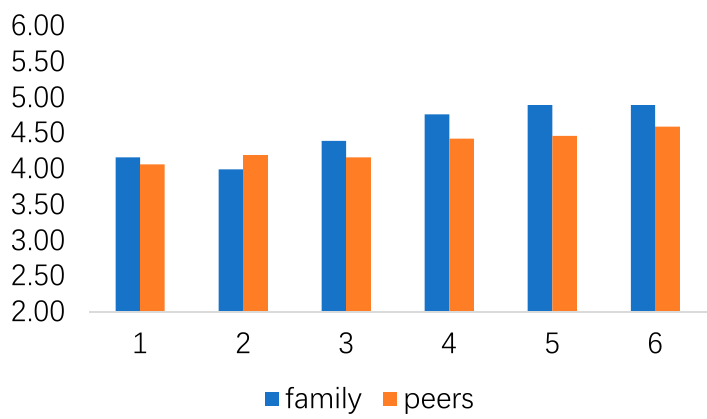
Figure 5. The relationship between subjective norms under different stimuli.